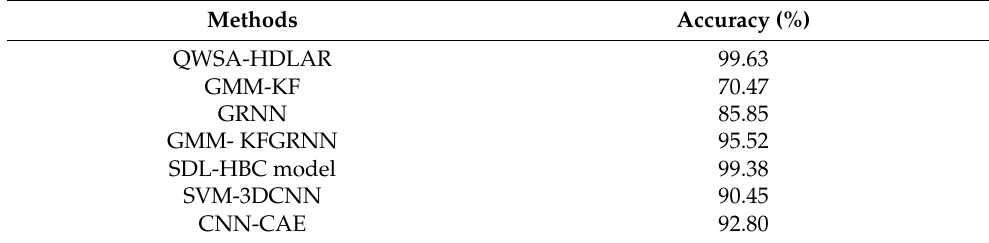
Table 4. Comparative accu y analysis of QWSA-HDLAR model on KTH dataset.